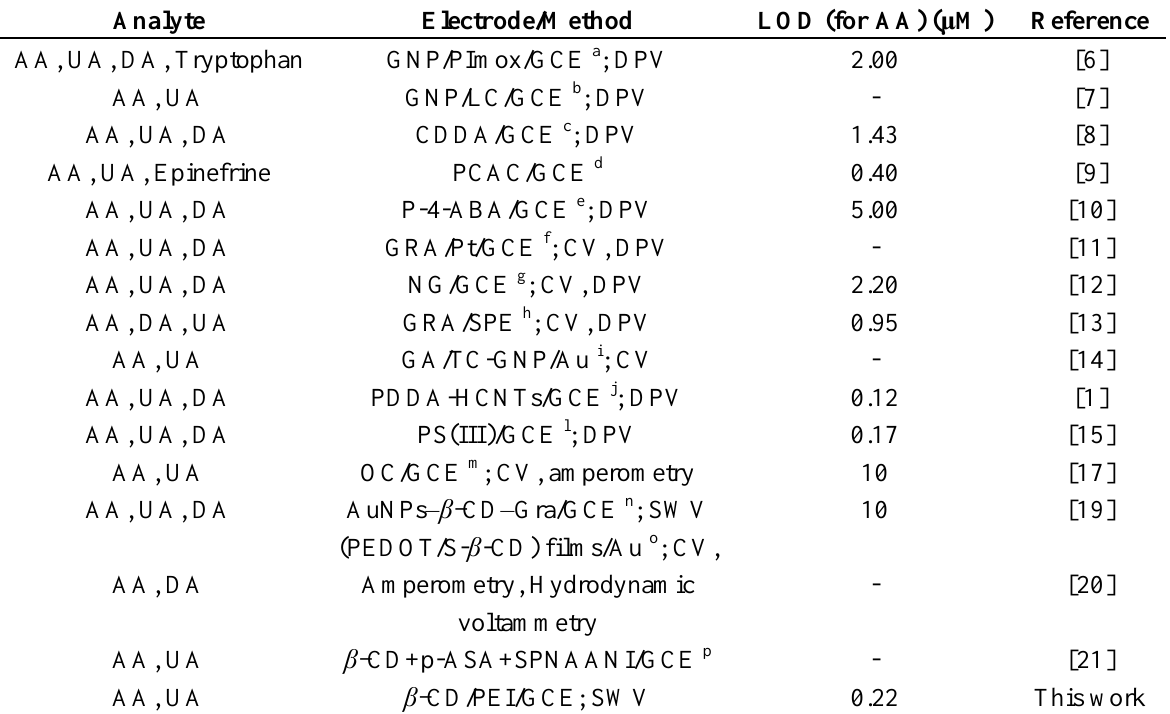
Analyte Electrode/Method LOD (for AA) (μM)